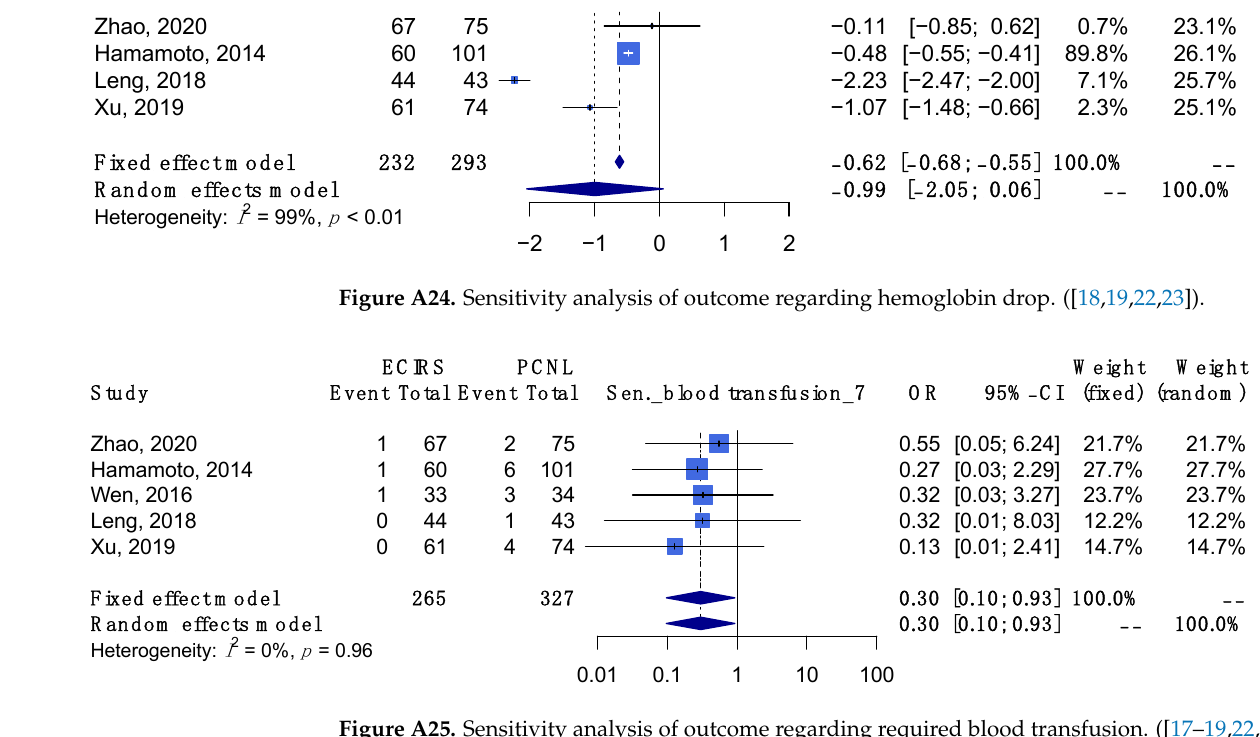
Figure A25. Sensitivity analysis of outcome regarding required blood transfusion. ([17–19,22,23]).